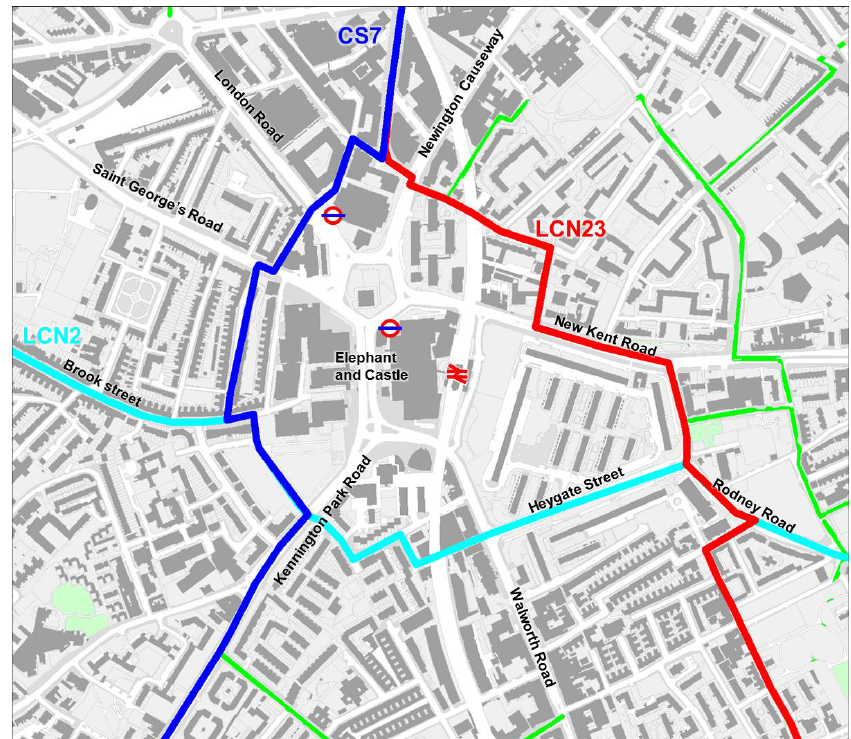
Figure 5. The figure describes the Elephant and Castle study area with the London Cycle Network; LCN23 in red, LCN02 in aqua, and London Cycle Superhighway CS7 in blue and green lanes in